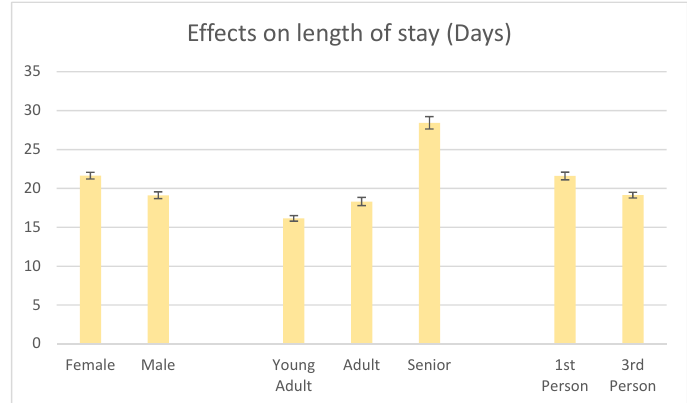
Figure 3. Results from the multivariate analysis. Sex, age and narrative voice of the adoption profile (first person vs. third person) were all found to significantly affect mean LOS ( p < 0.001). Standard error bars are shown.